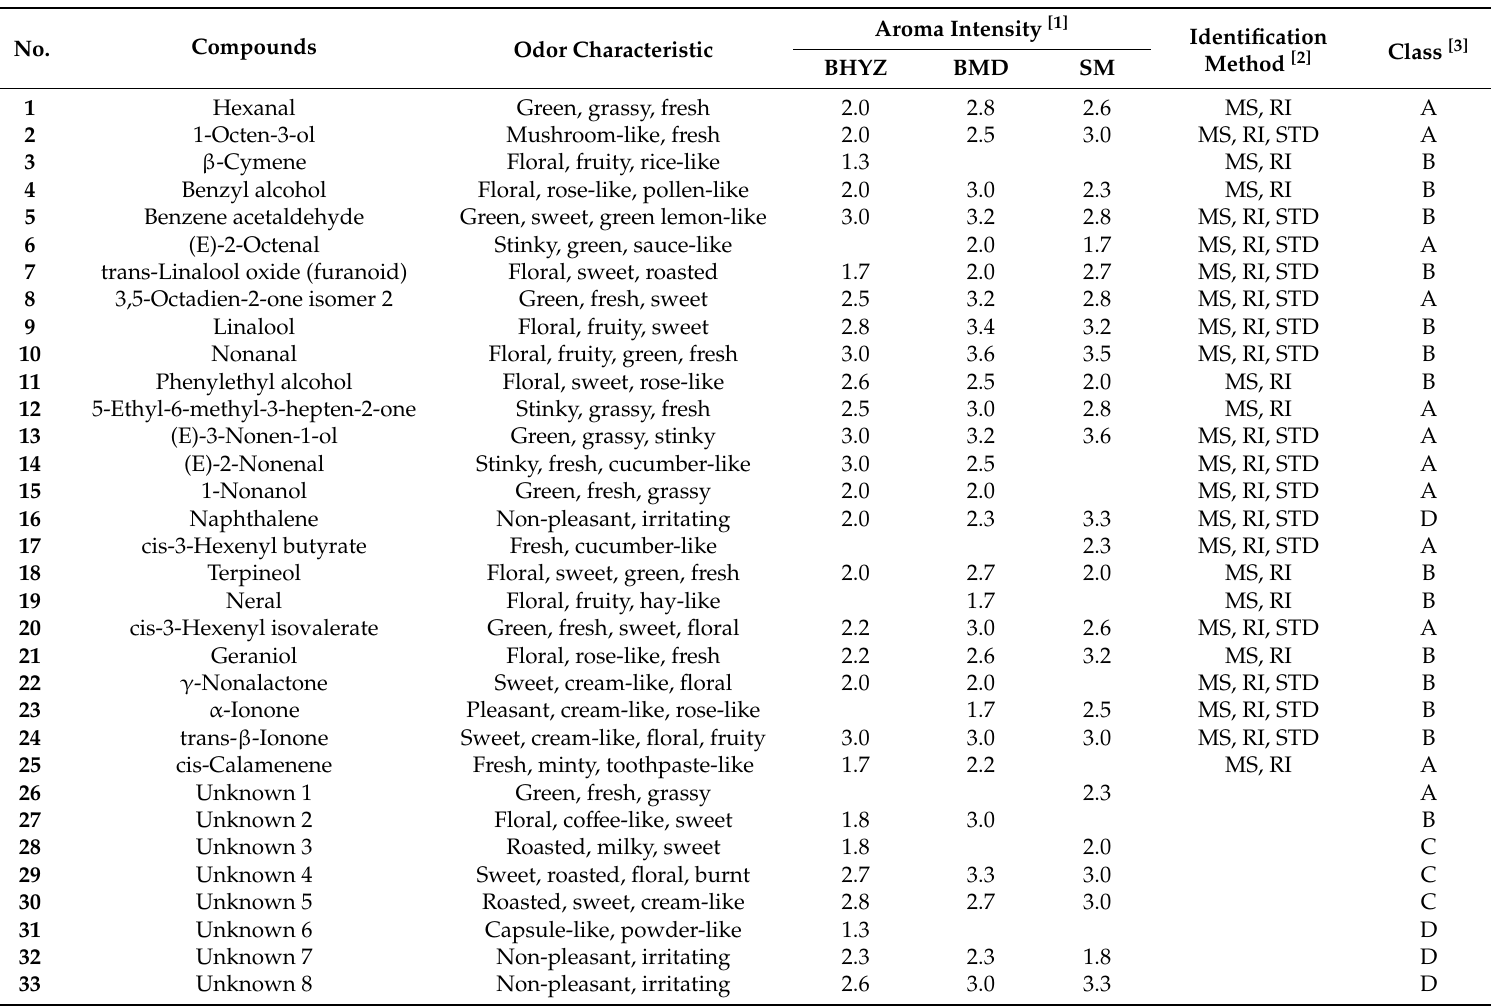
Table 2. Identified aroma-active compounds in white teas using GC–O /